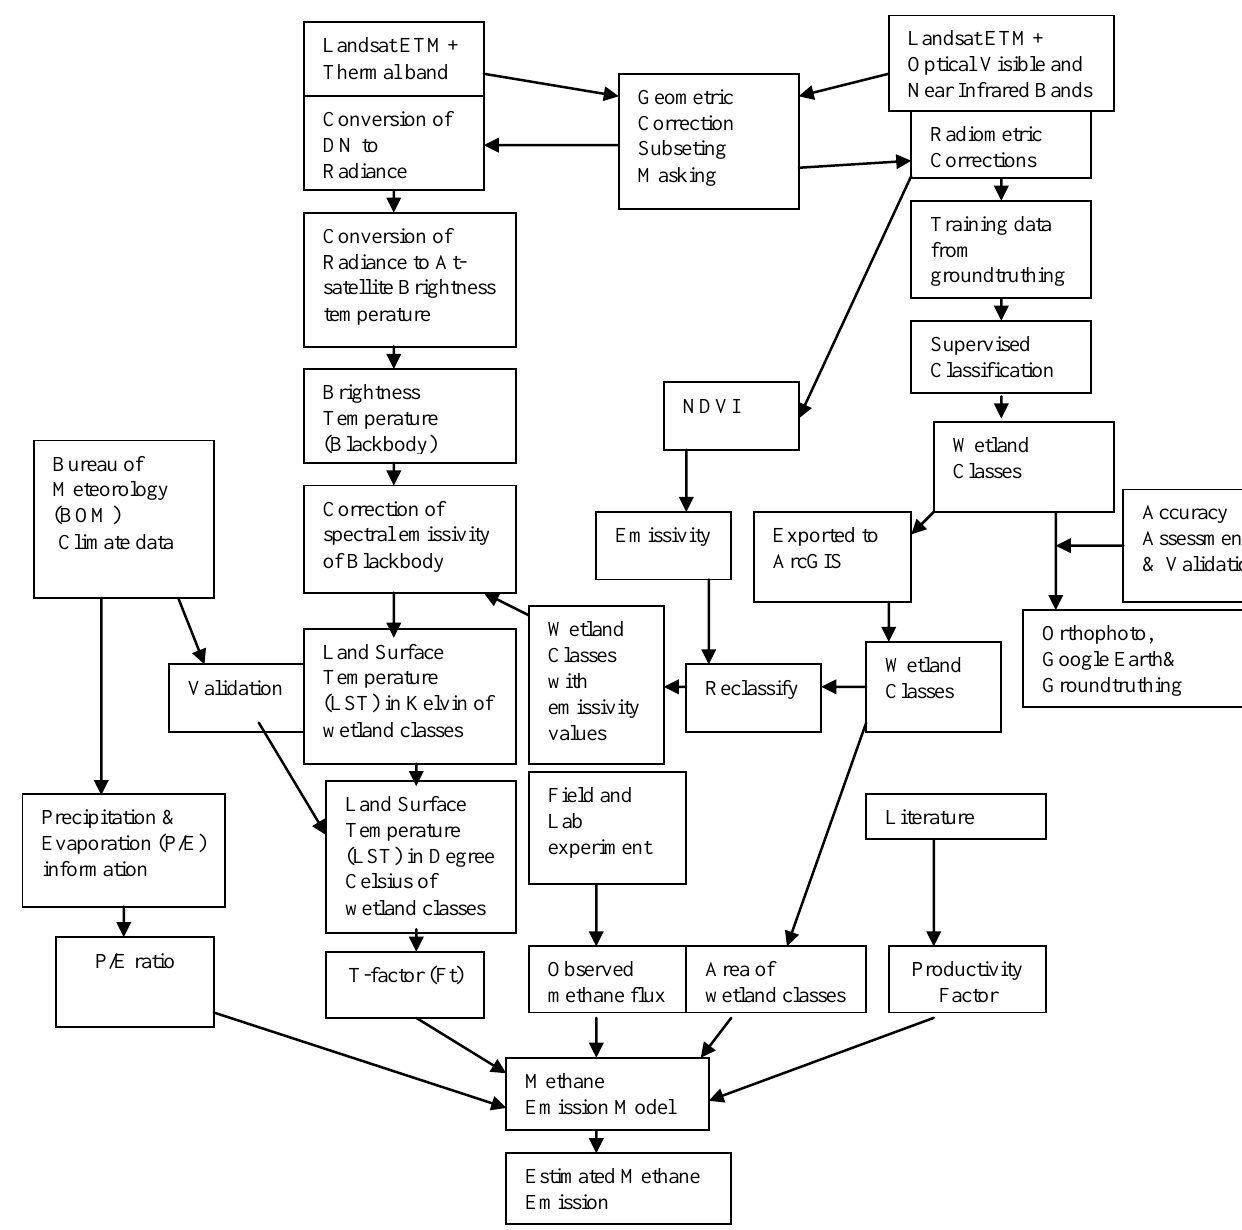
Figure 2. Schematic representation of